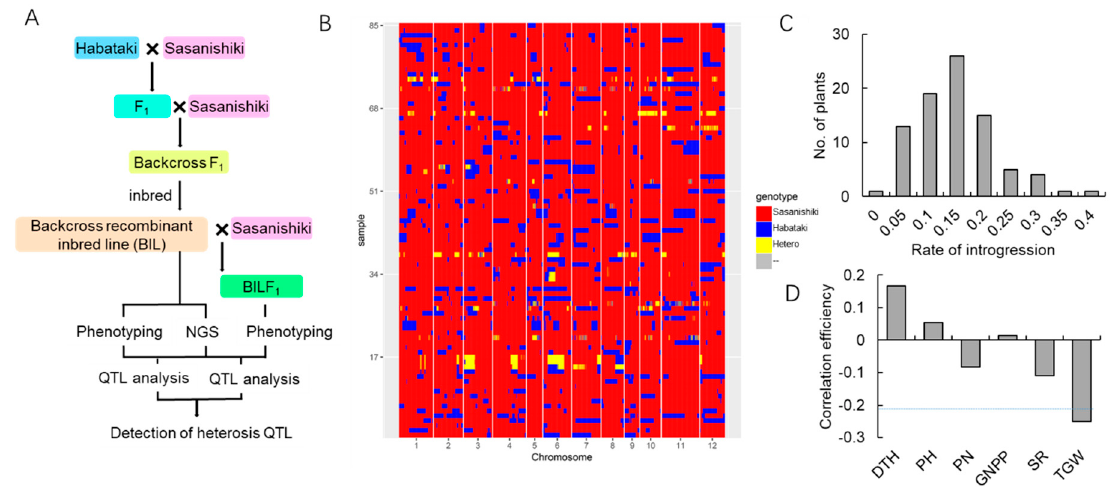
Figure 1. Schematic overview of the parent backcross recombinant inbred line (BIL) system construction and the map of genome-wide graphic genotypes. ( A ) The technology roadmap using genome sequence and quantitative trait locus (QTL) analysis of BILs and BILF 1 s to uncover heterosis-related loci for yield increase. ( B ) Graphic genotypes of 85 BILs were identified by a sliding window approach along each chromosome. Various colors represent di ff erent genotypes. ( C ) The introgression rate of the Habataki pedigree among the BILs. ( D ) The correlation between the introgression rate of the Habataki pedigree and yield-related traits. The dotted lines indicate significance at the 5% level.